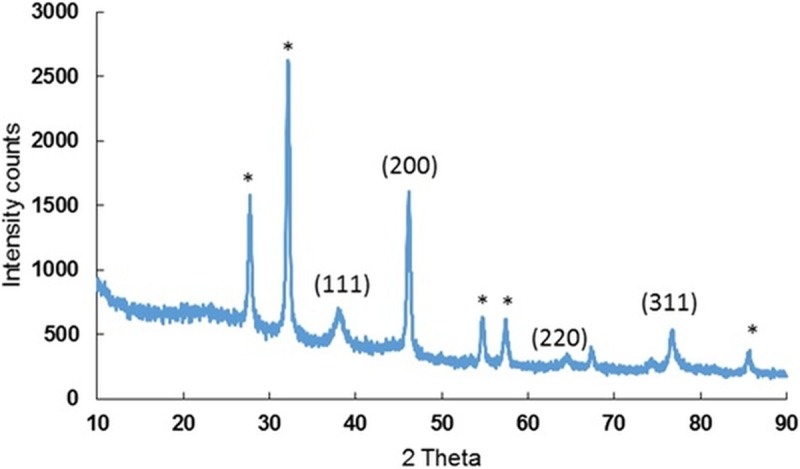
XRD analysis of the biosynthesized AC-AgNPs.